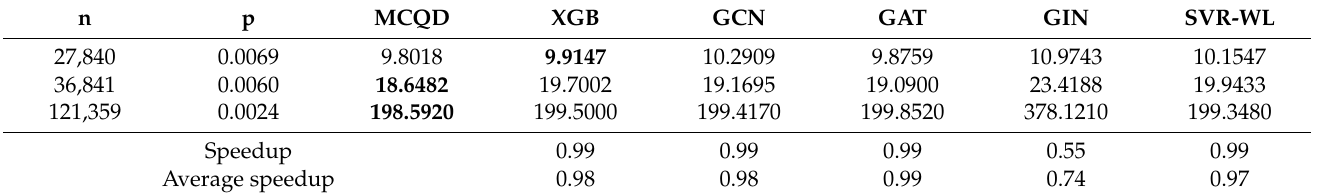
Table 5. Times that algorithms need to find the maximum clique for each graph from a test set of full product graphs. Best times are in bold.